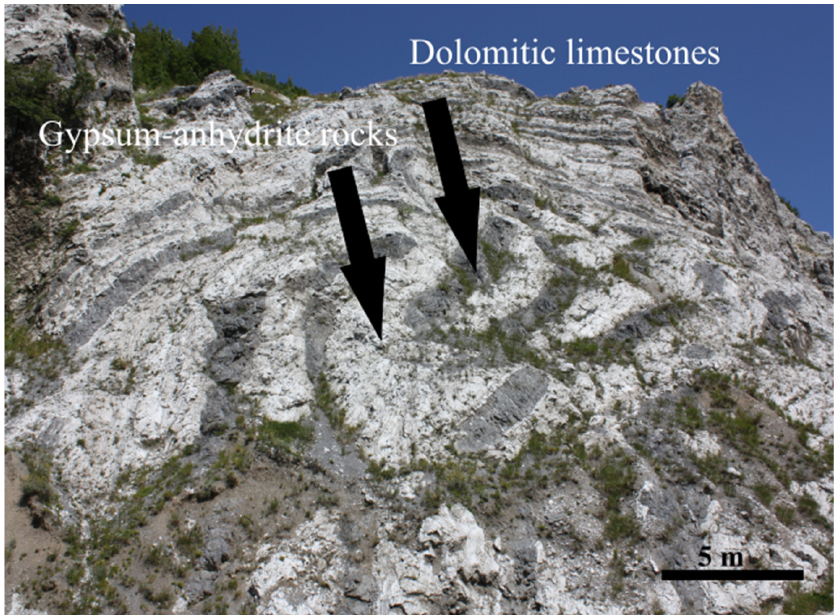
Figure 2. Spectacular outcrop of the Burano Formation in Val Secchia near Sassalbo, (Massa province, Tuscany) where you can observe the alternation of lighter colored levels of gypsum-anhydrite and darker levels of dolomitic limestones. Black quartzes are found mainly in anhydrite levels.